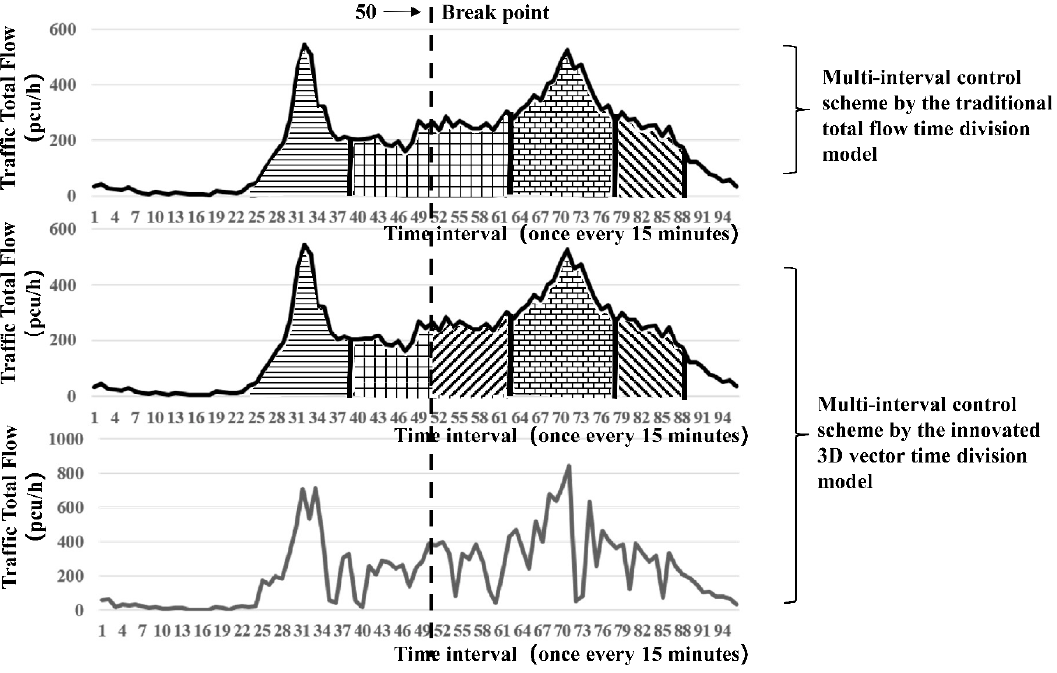
Figure 7. Scheme comparison diagram of the 3D vector time period division with the traditional total flow division (entire-day traffic flow at the intersection of Yangming North Road and Renmin East Road in Shaoxing on 23 June 2016). Table 1. Time-of-day division scheme under the traditional total flow time period division of the intersection at Yangming North Road and Renmin East Road.